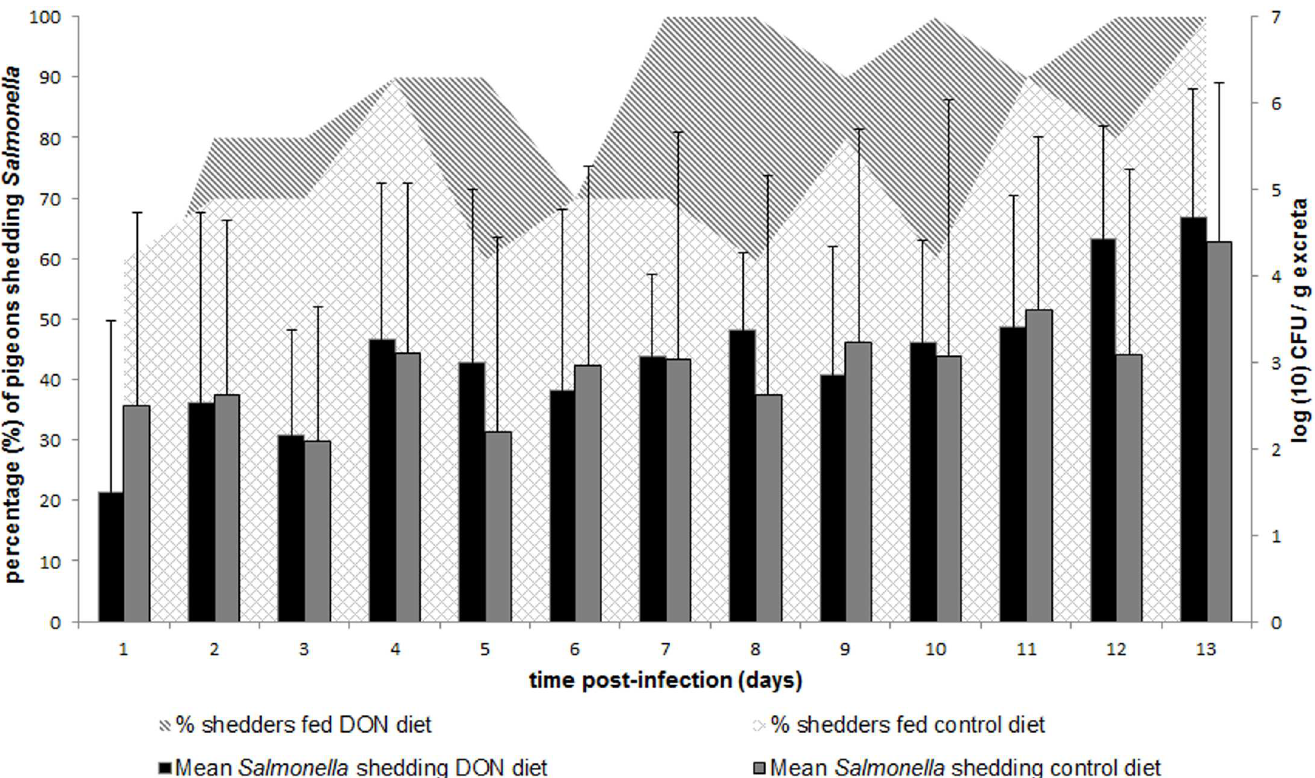
Fig 3. Salmonella fecal shedding. Pigeonswere fed either a control diet or a DON contaminated diet for 28 days. Post inoculation with a pigeon-adapted Salmonella Typhimurium variant Copenhagenstrain DAB69, Salmonella fecal shedding was assessed daily by countingthe numbersof Salmonella in excreta samples.Results are presentedas the mean number (+ SD) of CFU of Salmonella per gram of excreta and the percentage of pigeonsshedding Salmonella per experimental group.